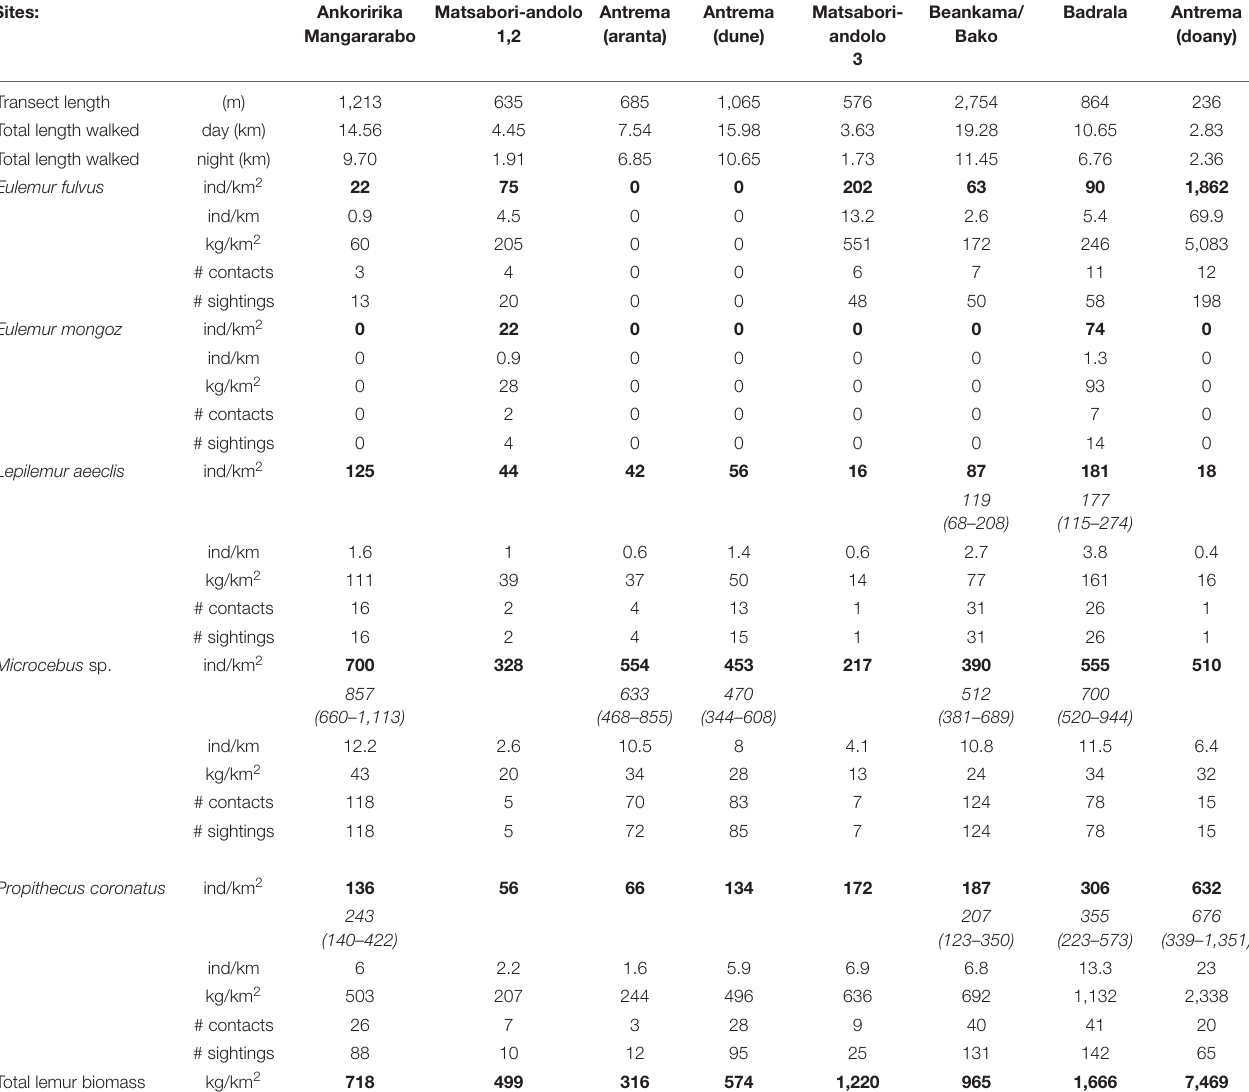
Results in italics (mean and 95% confidence interval) are generated by Distance Sampling (Distance 7), using a half normal/cosine detection function. Body mass used for calculating lemur biomass (rounded numbers) is for Propithecus: 3.7 kg; Microcebus: 0.062 kg; Lepilemur: 0.89 kg; Eulemur fulvus: 2.73 kg; Eulemur mongoz: 1.25 kg (Rasoloarison et al., 2000; Andriaholinirina et al., 2006; Pichon and Simmen, 2015; Gordon et al., 2016). The estimate of Propithecus density in Badrala is close to a previous complete enumeration of groups at 283 inds.km − 2 (adults and juveniles from 16 groups over 24 ha; 321 inds.km − 2 including infants; Pichon, 2012; see also Salmona et al., 2014). Bold indicate density and biomass per km 2 .